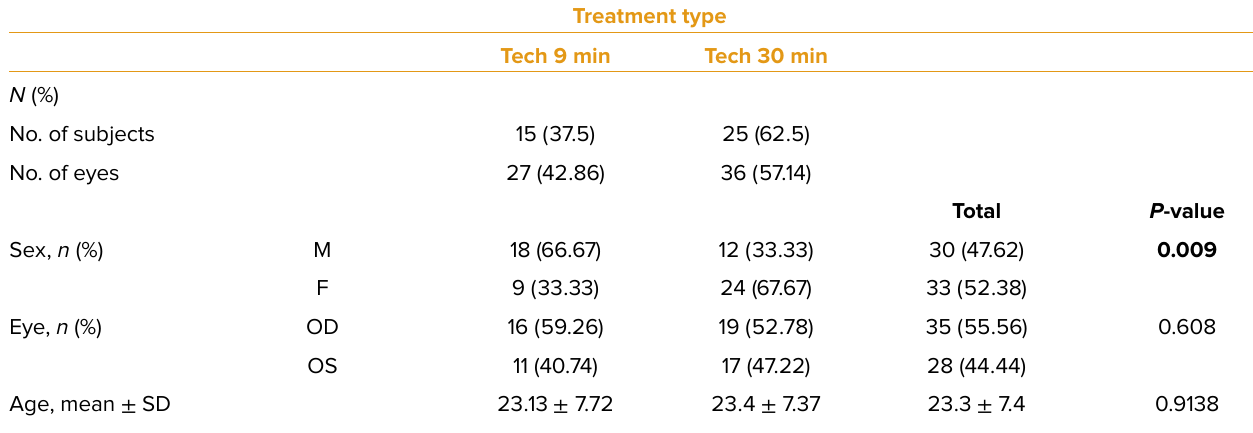
Table 1. Patient characteristics at